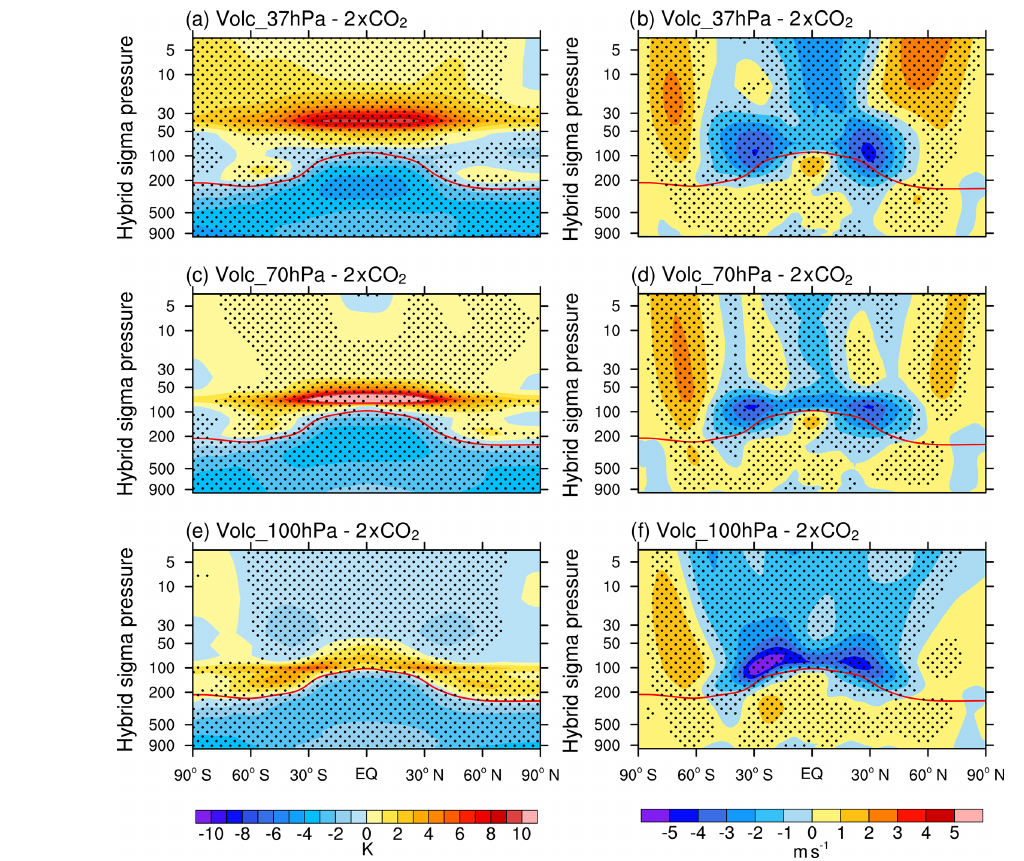
Figure 7. The changes in zonal average temperature (a, c, e) and winds (b, d, f) in the three stratospheric sulfate simulations (slab ocean simulations) relative to the 2XCO2 simulation. Position of the tropopause in each case is marked as a red line. The hatched areas in the plot show the regions where the changes are significant at the 5% significance level. The significance level is estimated using Student t test from 60 annual means of the experiments.